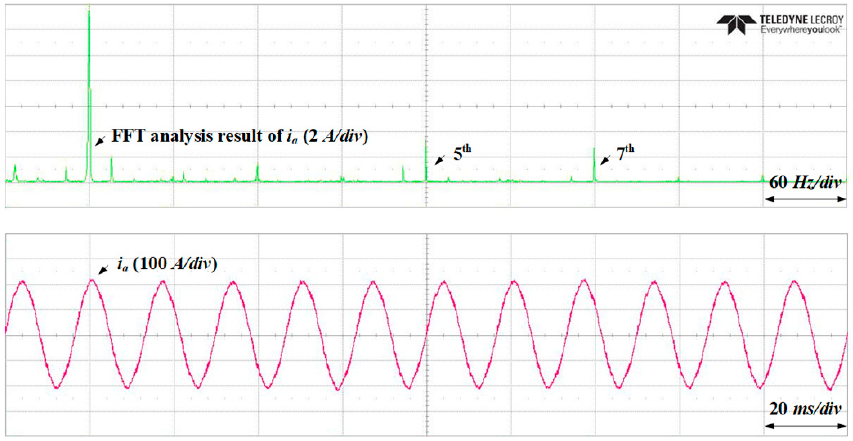
Figure 22. Experimental results when a harmonic compensation method is applied: conventional method.